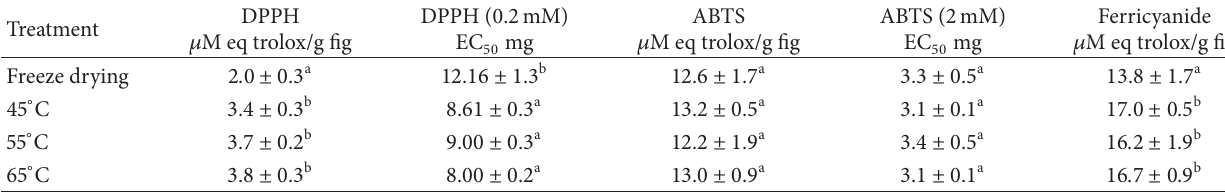
Table 5: Antioxidant activity of dried ground figs.